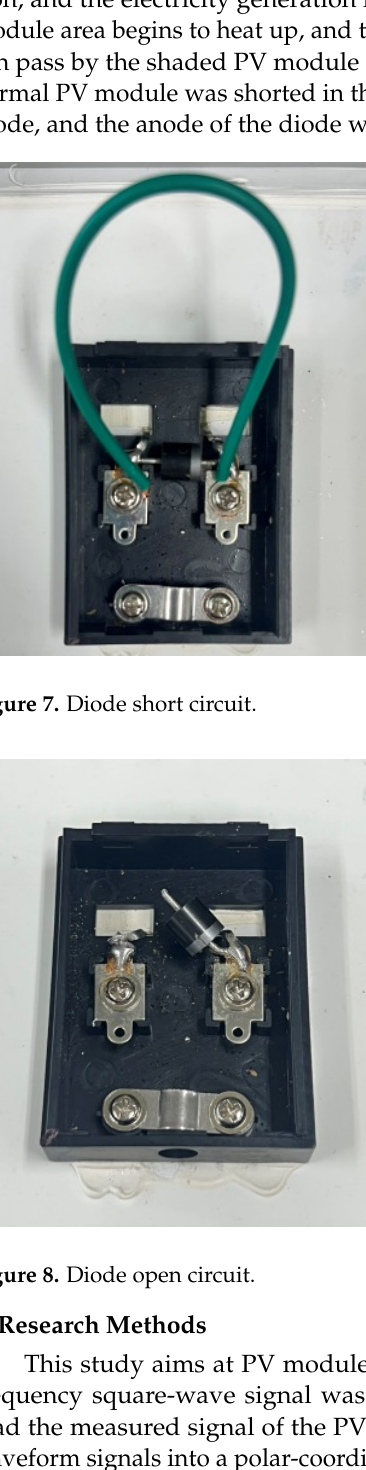
Figure 6 . Mild breakage of the PV module .